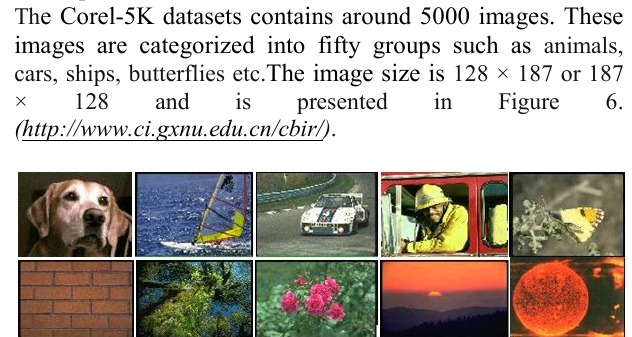
Figure 5. Sample images of Corel-1k database Description of Corel-5K dataset :